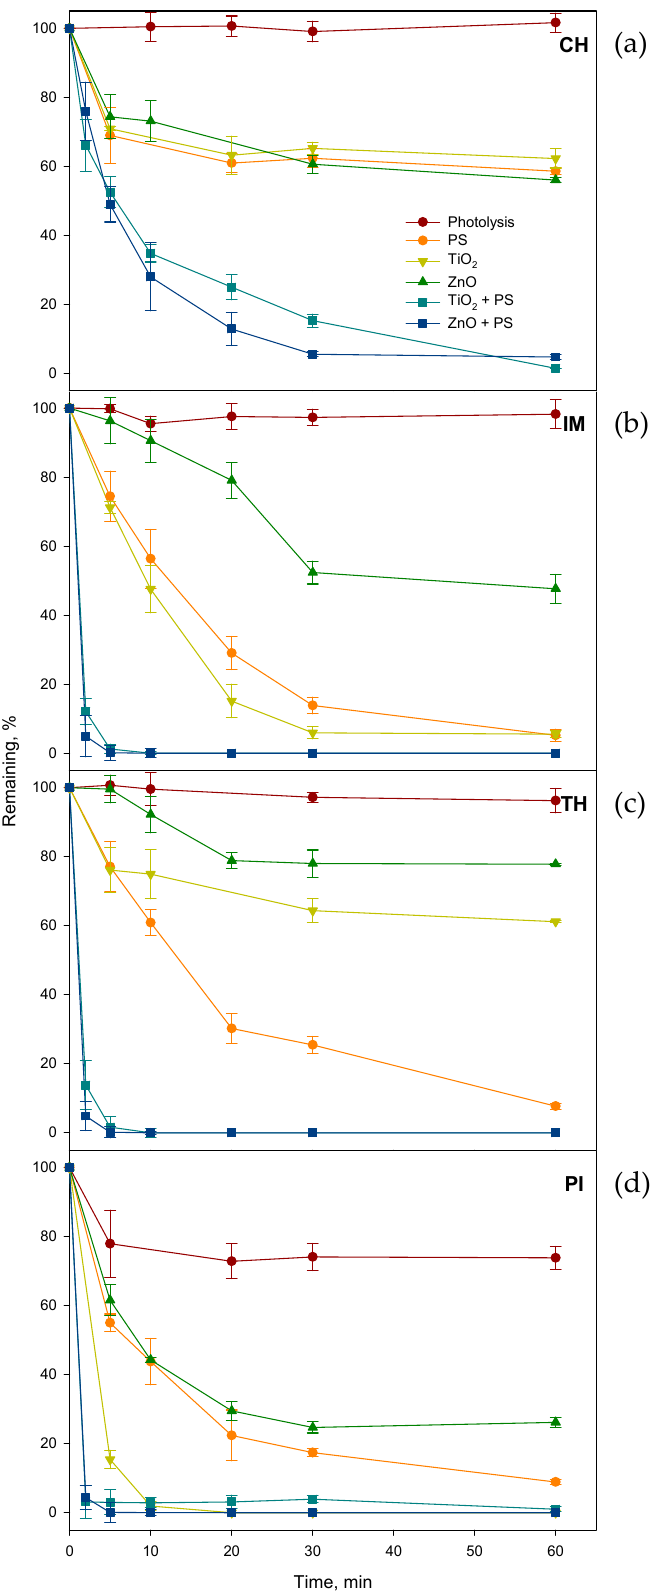
Figure 1. Photocatalytic processes comparison in pure water spiked at 1 mg L − 1 of target com- pounds ([PS] = 200 mg L − 1 ; [TiO 2 ] = 200 mg L − 1 ; [ZnO] = 350 mg L − 1 ). ( a ) Chlorantraniliprole; ( b ) Imidacloprid; ( c ) Thiamethoxam; ( d )